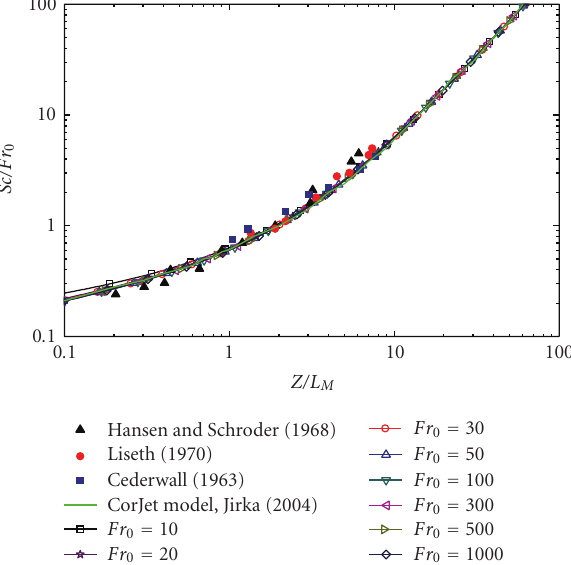
Figure 3: Concentration decay along the centerline for pure jets.